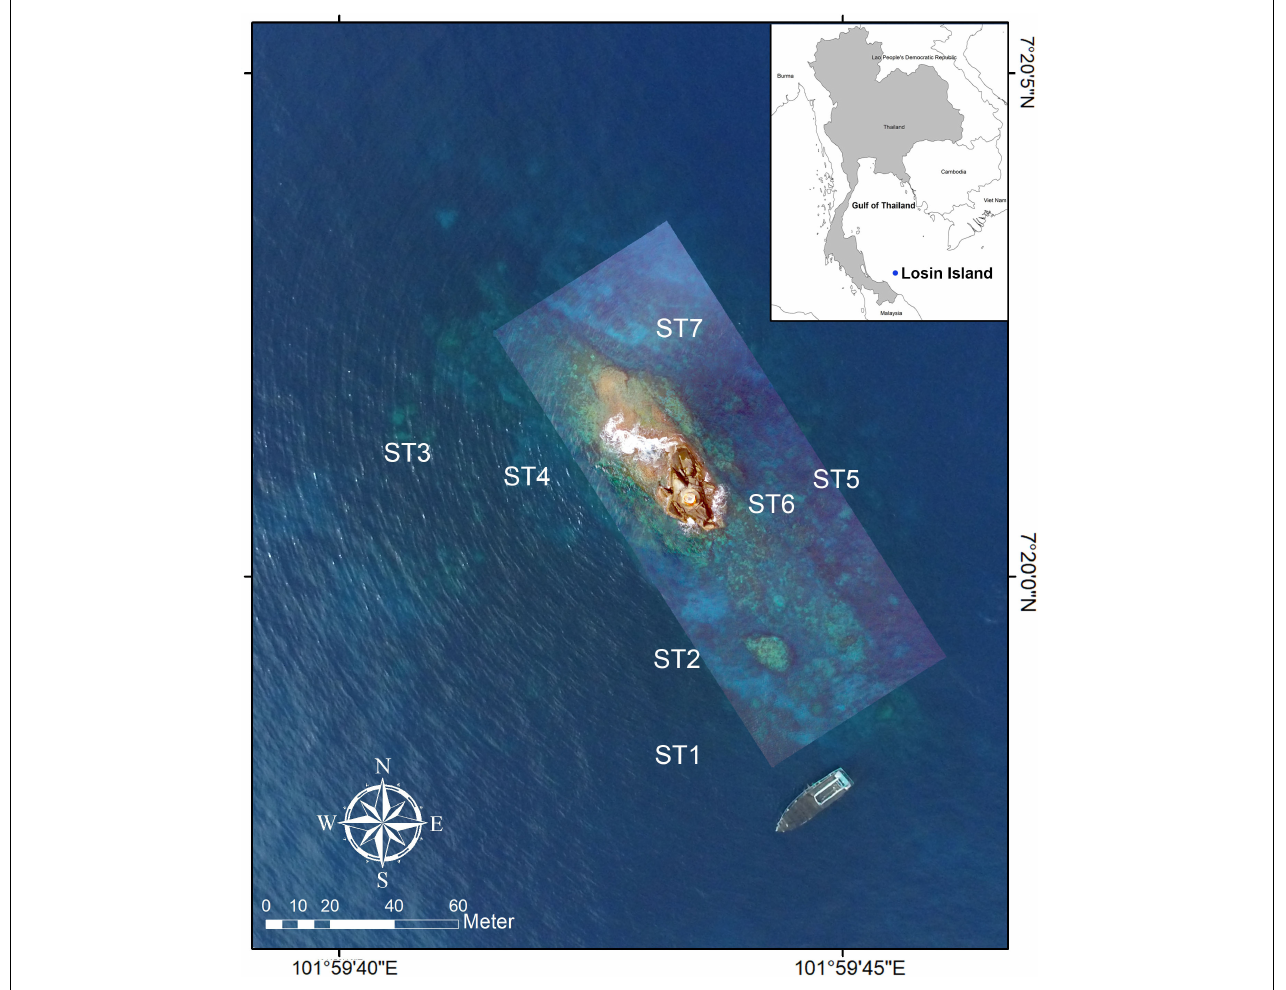
FIGURE 1 | Location of Losin Pinnacle; 7.33360051658N, 101.995261722 E. Shallow survey sites at 10 m comprise ST2, ST4, and ST6, while deep surveys at 20 m comprise sites ST1, ST3, and ST5. All surveys were conducted in an anticlockwise direction, staying parallel to the actual pinnacle. Sites ST1, ST3, ST5, and ST7 were used to collect physical environmental